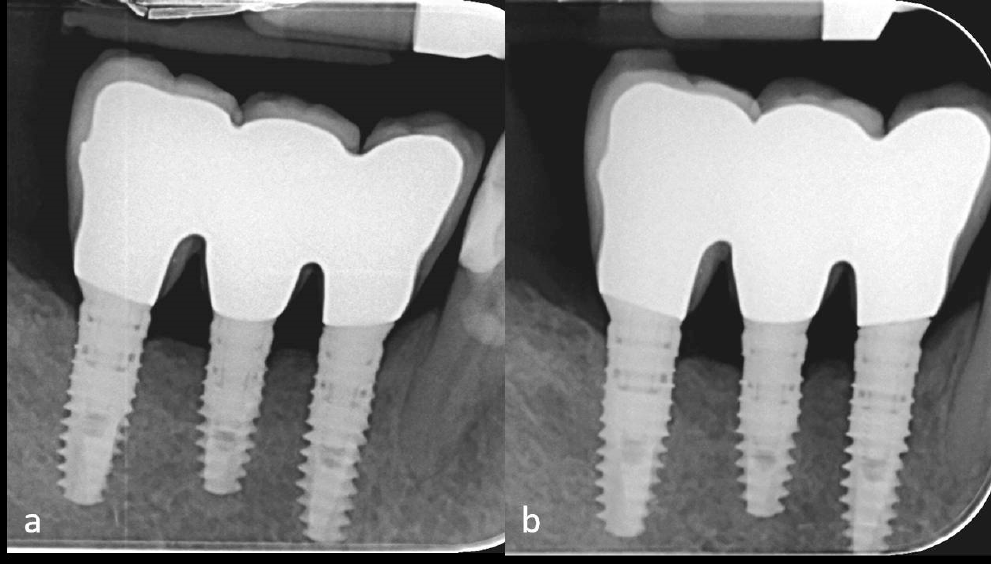
Figure 14. Intraoral radiographies performed 4 years ( a ) and 6.5 years ( b ) after implant rehabilitation show good maintenance of the peri-implant bone level.